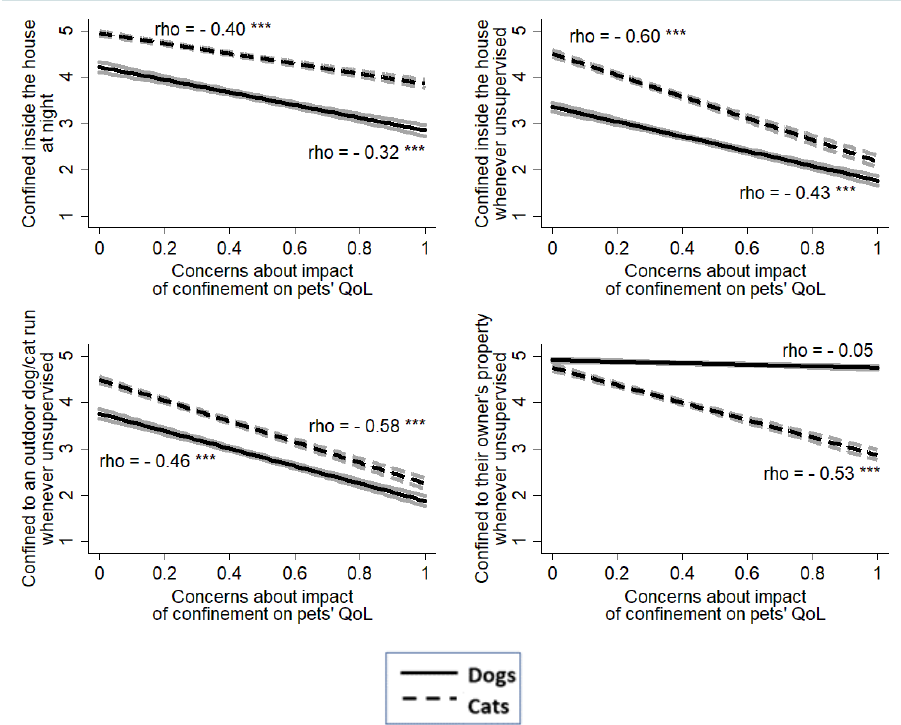
Figure A1. Bivariate associations between concerns about impact on QoL and individual items on pet confinement, separately for dogs (in 1291 dog owners) and cats (in 1146 cat owners); Spearman’s correlation coefficients (rho) are presented for each line with significance level denoted by the asterisk (*** p > 0.001).